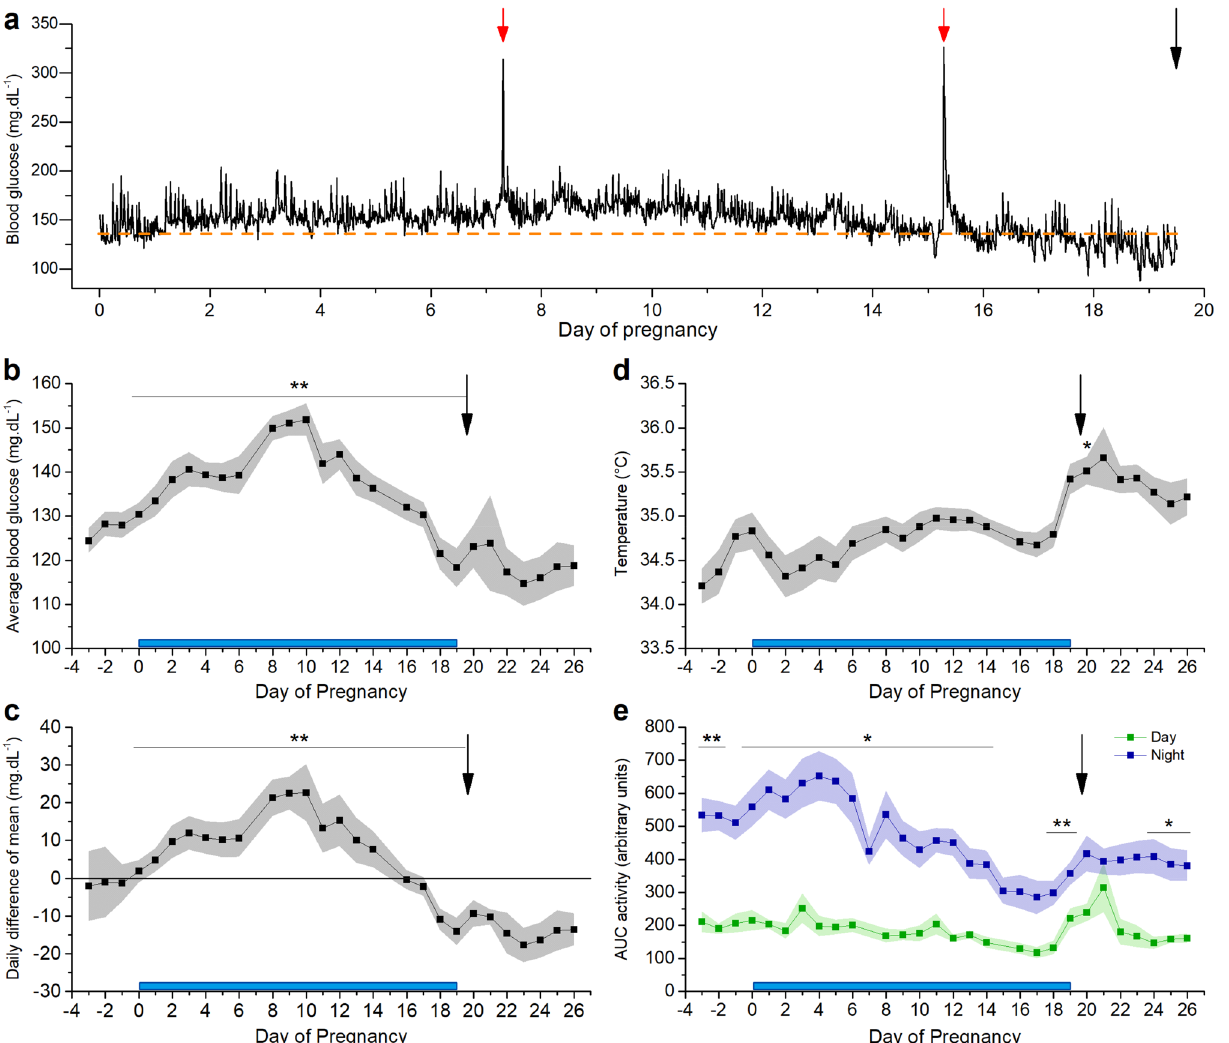
Figure 4. Standard properties extracted from CGM data before, during and after pregnancy. Blue bar: time of pregnancy. Black arrow: delivery. ( a ) Glucose levels of a full pregnancy of one individual mouse. Red arrow: OGTT. Orange dashed line: average glucose concentration 24 h before pregnancy. ( b ) Arithmetic mean of glucose values ± s.e.m. for every 24 h. ( c ) Arithmetic mean of daily difference of the overall mean ± s.e.m. for 24 h. ( d ) Arithmetic mean of s.c. body temperature ± s.e.m. for every 24 h (one-way repeated measures ANOVA p < 2 × 10 –16 , posthoc pairwise comparison with Bonferroni correction reveals a significant increased temperature on day 20, p < 0.05). ( e ) Arithmetic mean of area under the curve (AUC) of activity ± s.e.m. for day and night. ( b – e n = 10 mice, significance testing was performed with two-way repeated measures ANOVA or post-hoc pairwise t-test between the daytime and night time activity with Bonferroni